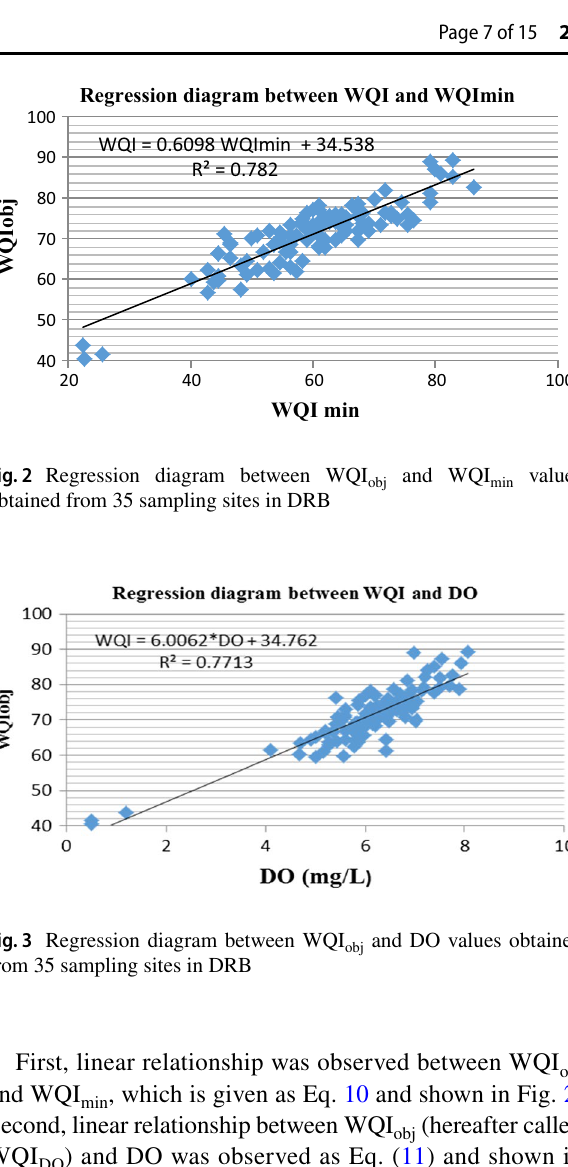
obj and DO values obtained